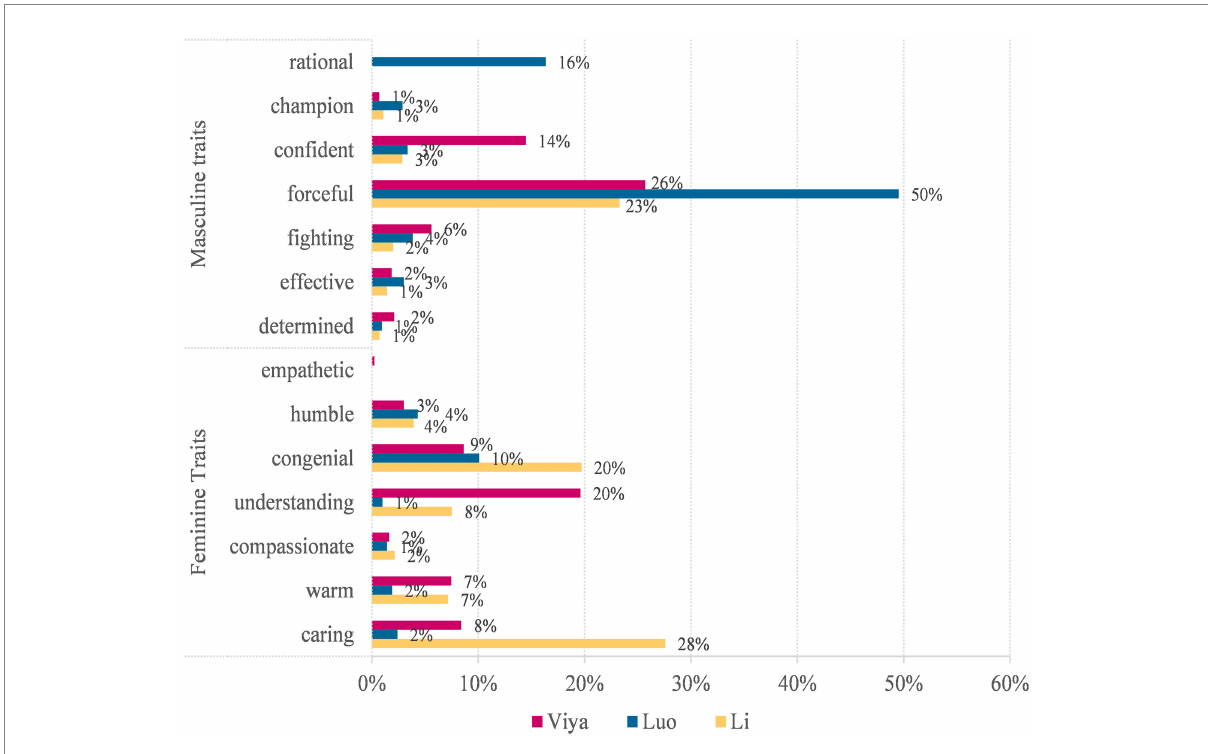
FIGURE 1 Distribution of personality traits among key opinion leaders